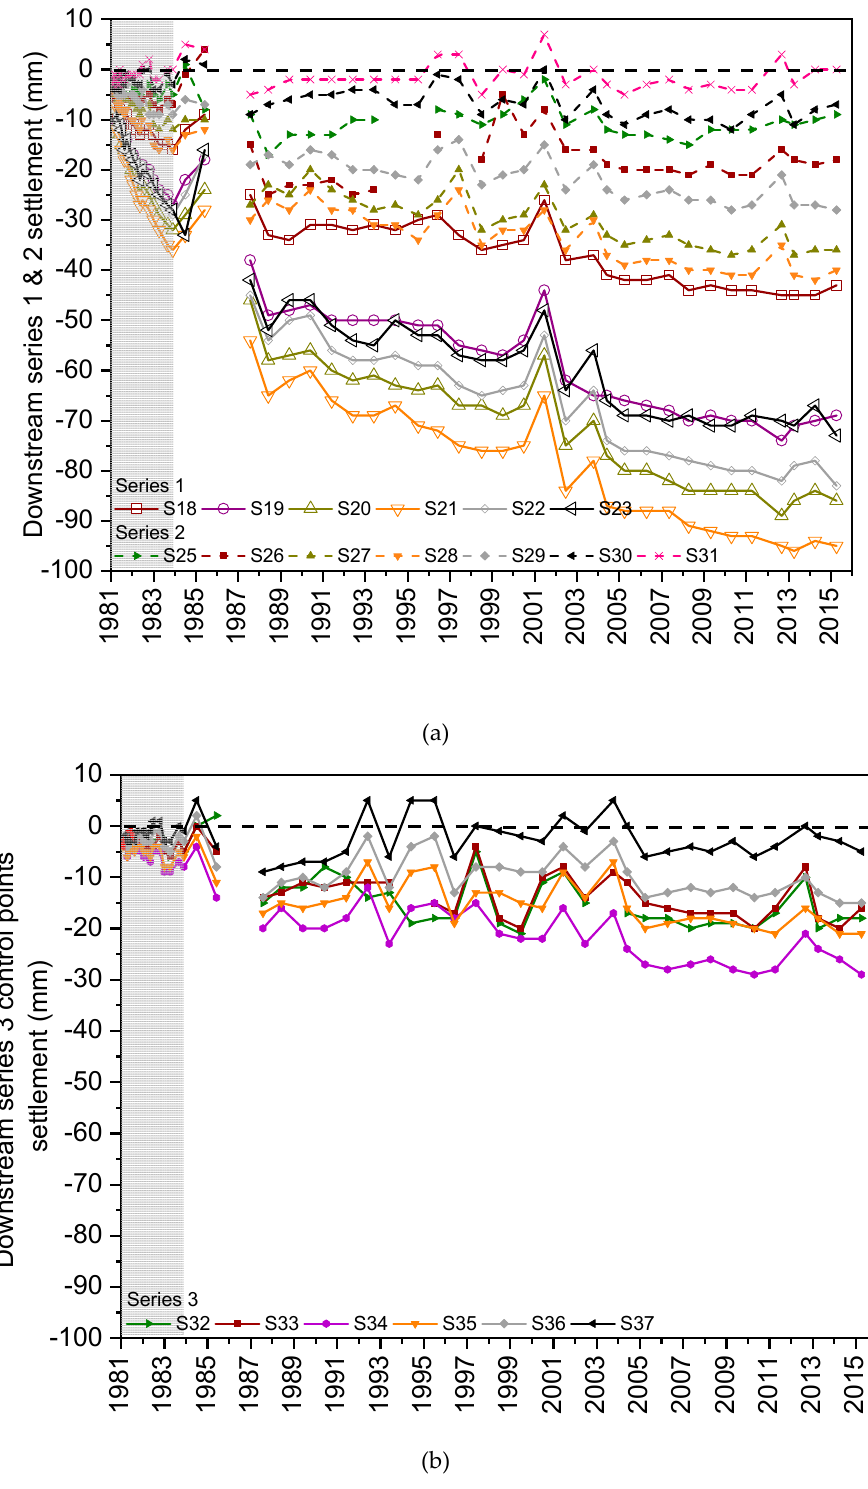
Figure 6. Time evolution of settlements for the D/S shoulder: (a) Series 1 control stations S-18 to S-23, and Series 2 control stations S-25 to S-31; (b) Series 3 control stations S-32 to S-37. Both graphs have the same scale on the x and y-axis for comparison purposes. Points with the same symbols, filled or unfilled, lie along the same cross-section, perpendicular to the dam axis. The shadowed area corresponds to the first three filling cycles (1981–1984), and is not taken into account in this study.